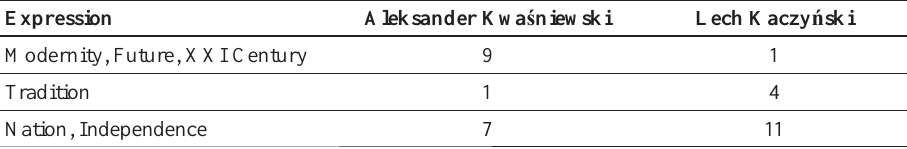
Table 1. Opening Presidential Speeches –frequency of selected expressions